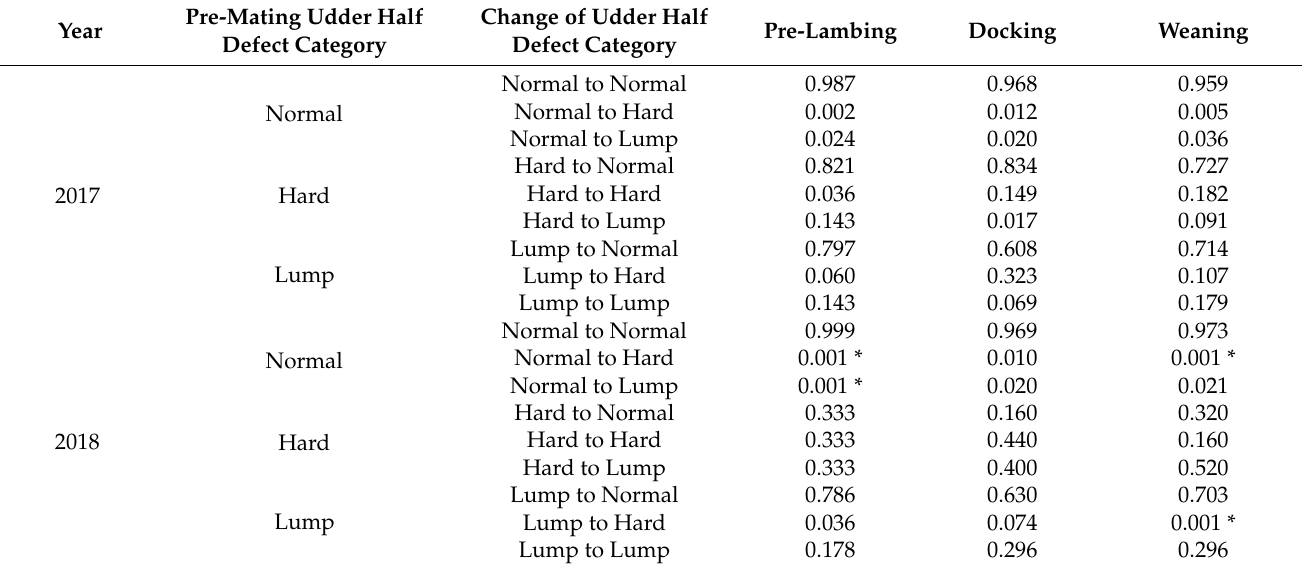
Table 3. Predicted probability (Pp) of udder half defect occurrence in non-dairy Romney ewes at pre-lambing, docking, and weaning based on pre-mating udder half defect category from 1962 udder halves (981 ewes) in 2017 and 1538 udder halves (769 ewes) in 2018 (Study